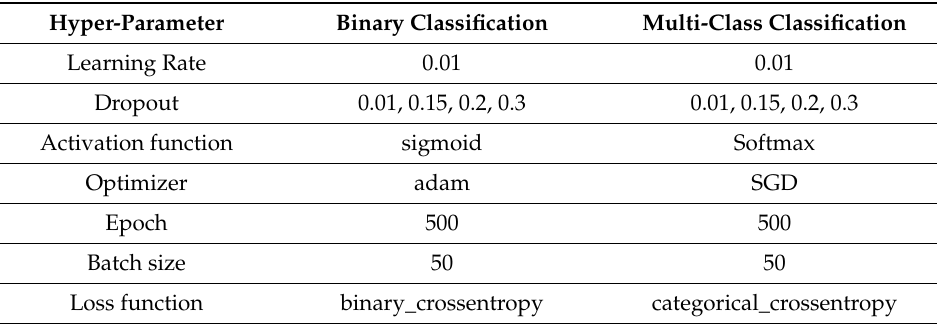
Table 4. Hyper-parameters of experiments.